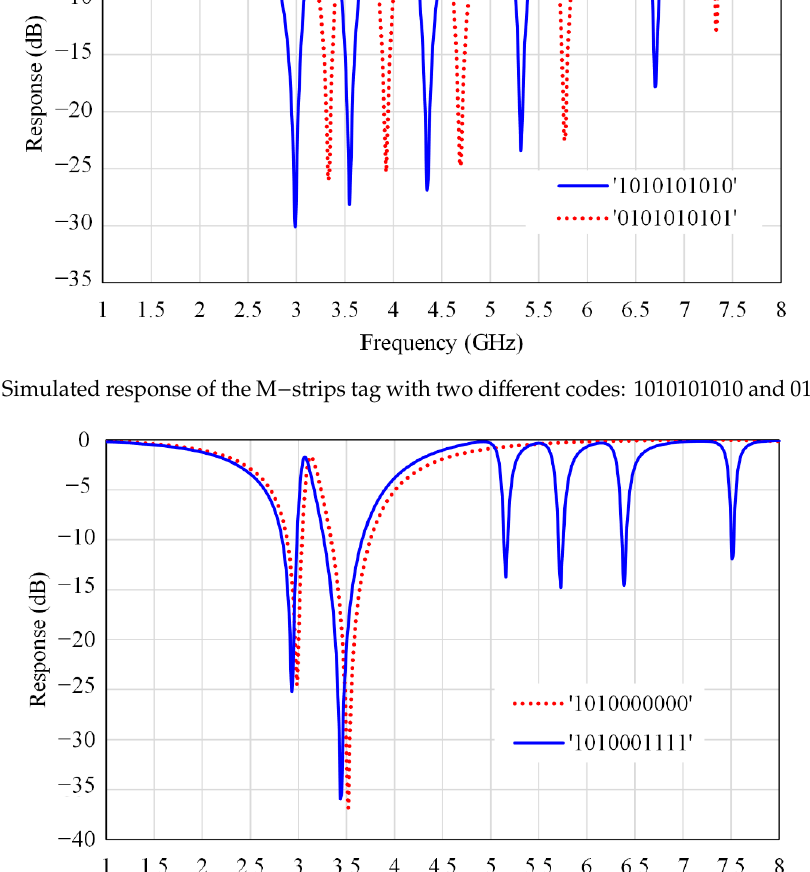
Figure 7. Simulated response of the M − strips tag with two different codes: 1010000000 and 1010001111.